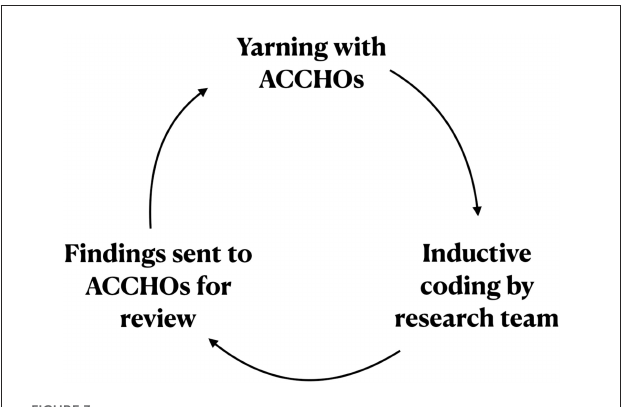
FIGURE3 A cyclical approach to thematic analysis. This flowchart summarizes the cyclical approach to analysis utilized in this study. ACCHO, Aboriginal Community Controlled Health